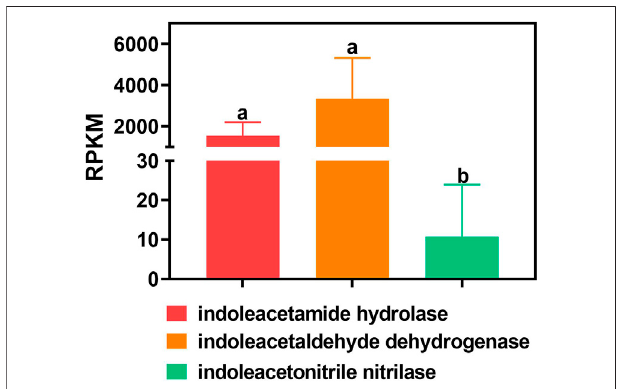
FIGURE 2 | Gene abundance of different bacterial IAA synthetases in all samples. One-way ANOVA was used to analyze variations among all the treatments. Different small letters indicate signi fi cant differences at the p < 0.05